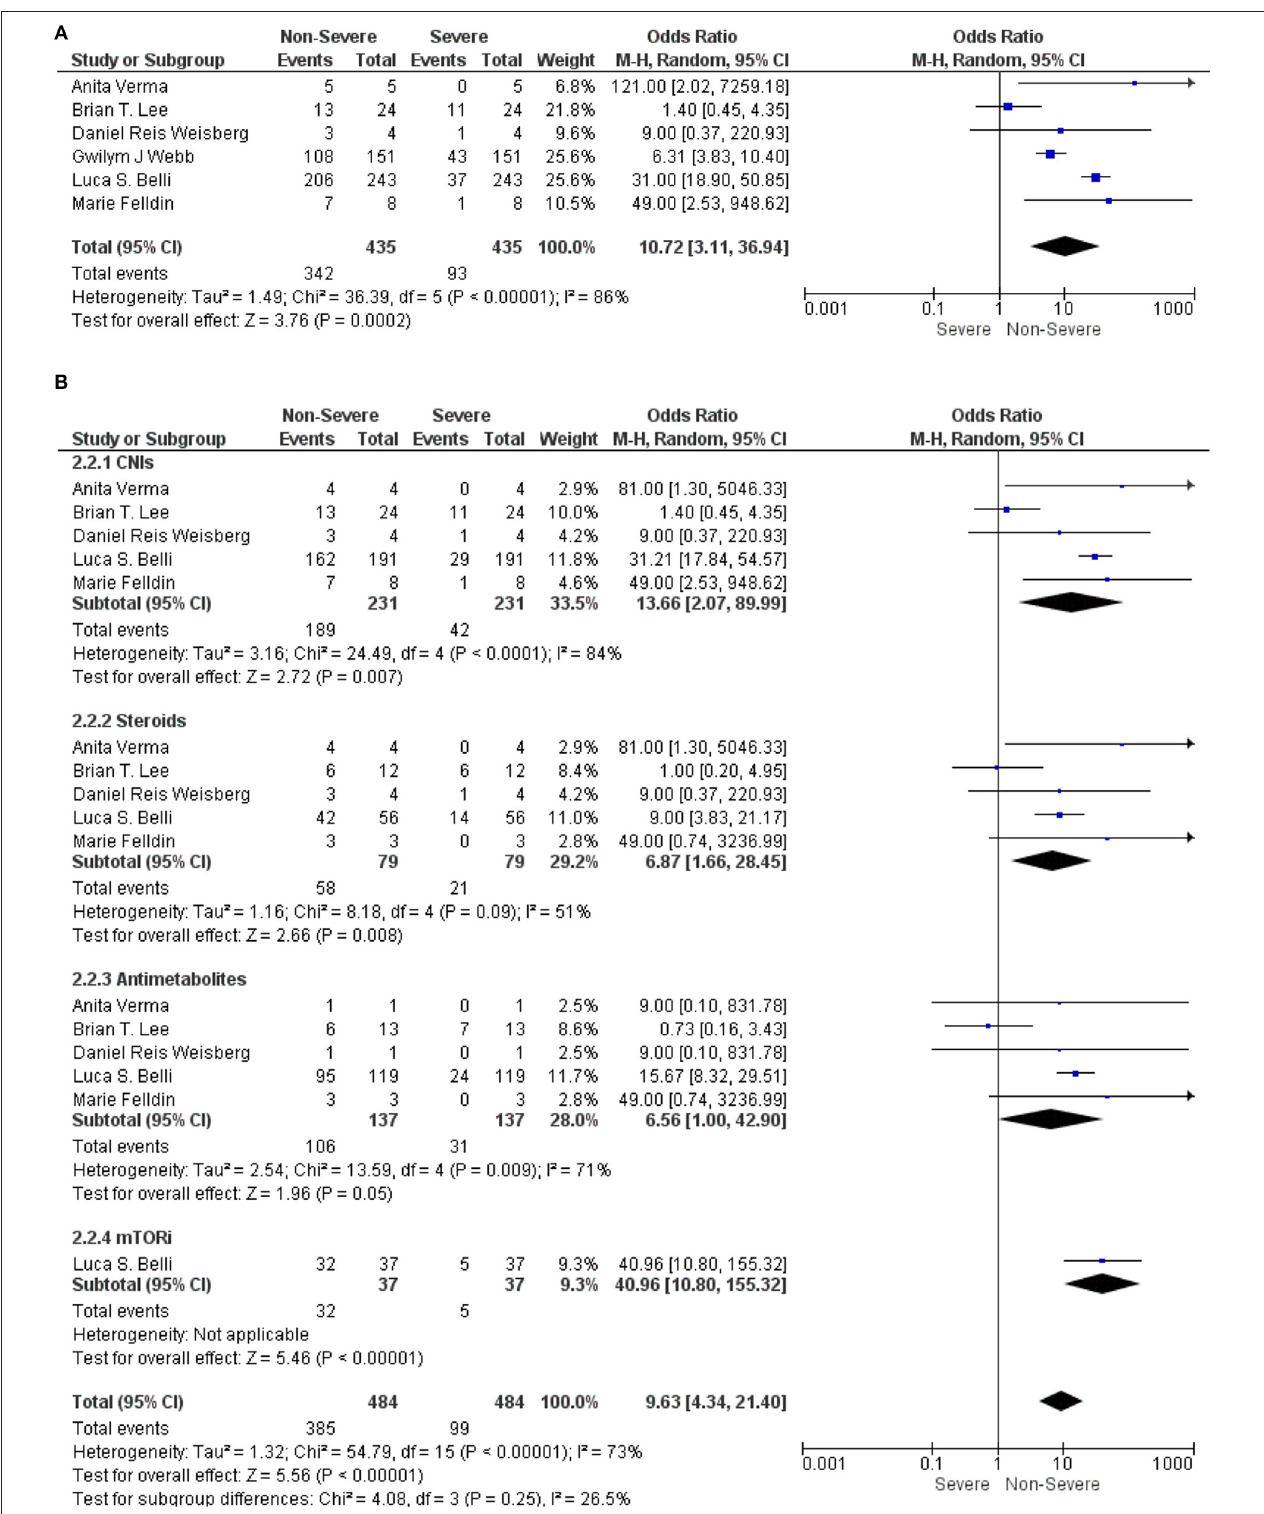
FIGURE 2 | (A) Forest plots for an association between the non-severe and severe liver transplantation (LT) recipients with COVID-19 for the overall immunosuppressants (ISs). (B) Forest plots for an association between the non-severe and severe LT recipients with COVID-19 with a subgroup analysis for the calcineurin inhibitors (CNIs), steroids, antimetabolites, and mammalian target of rapamycin inhibitors (mTORis) therapy.